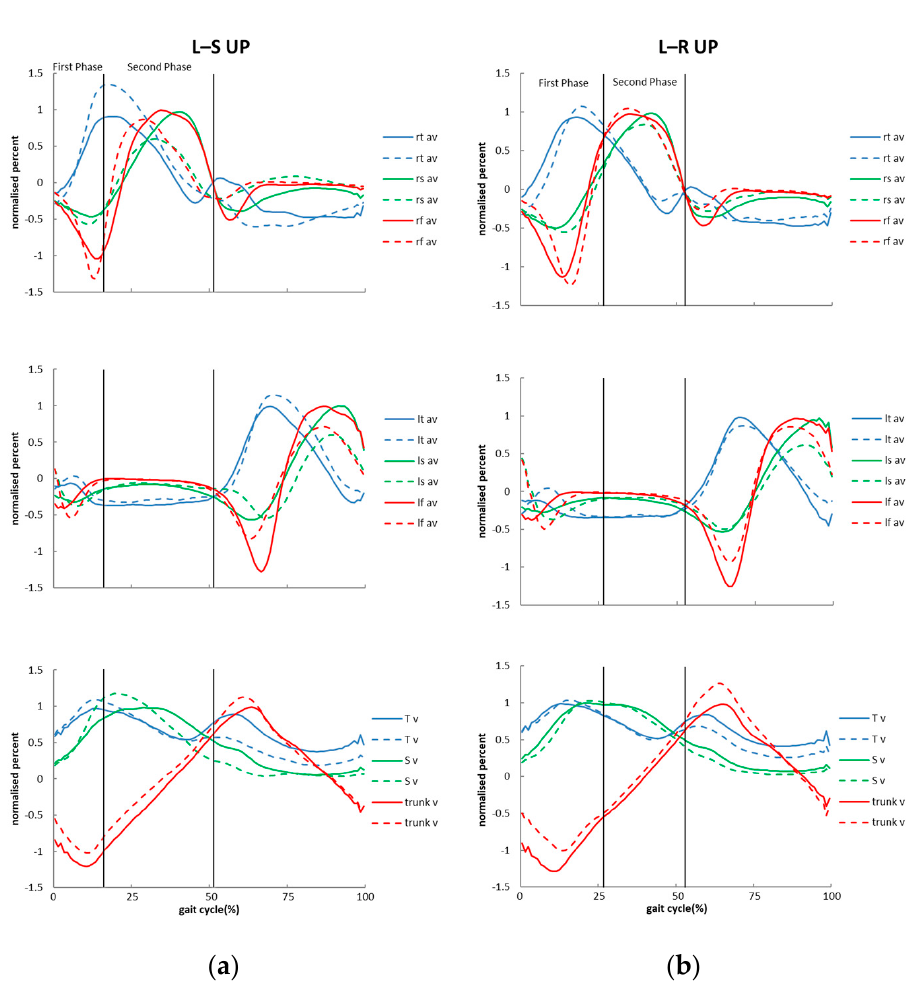
Figure 6. Average profile of the parameters: ( a ) during L-S UP and ( b ) during L-R UP. rt indicates the hip of leading limb, lt indicates the hip of trailing limb, rs indicates the knee of leading limb, ls indicates the knee of trailing limb, rf indicates the ankle of leading limb, lf indicates the ankle of trailing limb, trunk is trunk, T indicates the thigh of the leading limb, S indicates the shank of the leading limb, aa indicates angular acceleration, av indicates angular velocity, a indicates acceleration, and v indicates velocity. The dashed lines indicate transition stride. The solid lines indicate the stride before transition